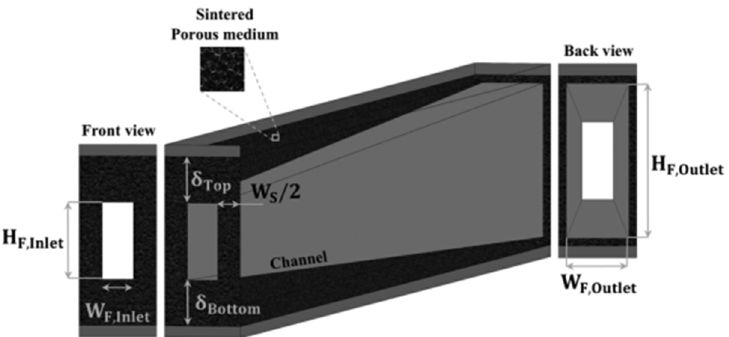
Figure 6. Highly divergent microchannel model [93].